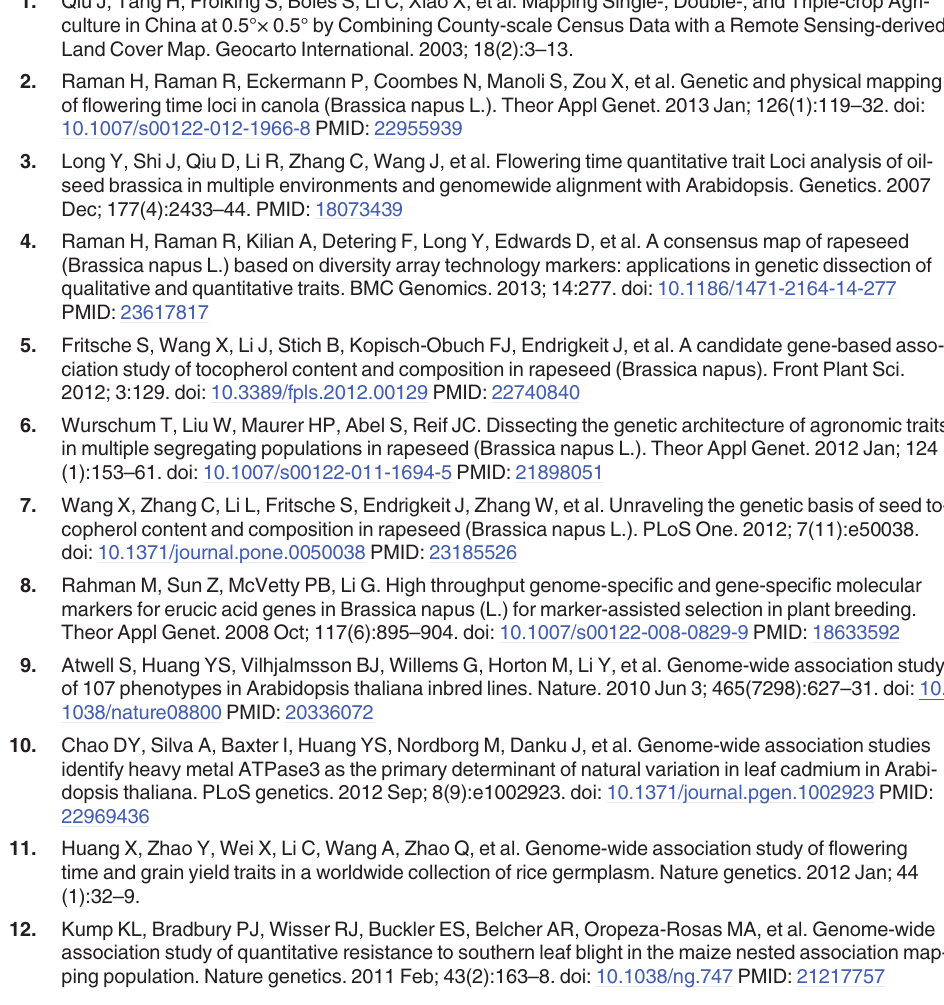
S6 Table. All the pair of interacting SNPs detected in the epistasis